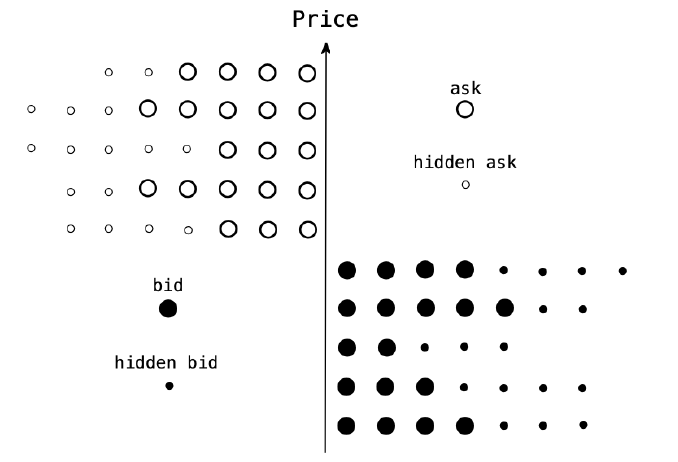
Figure 2. An image of a real trading board in a state of equilibrium immediately before a share of security is traded. In addition to displaying supply and demand with the large point limit prices on the board, potential supply and demand is displayed by the small points, and the traders are all in a state of subjective equilibrium. If nobody changes the subjective equilibrium for any reason, the market equilibrium is sustained without any trades being